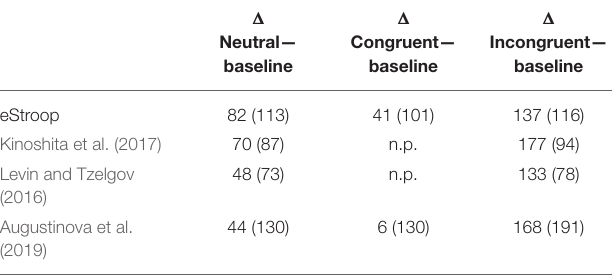
TABLE 3 | Delta values (standard deviations) calculated by subtracting mean RT of neutral words, congruent words, and incongruent words to the baseline